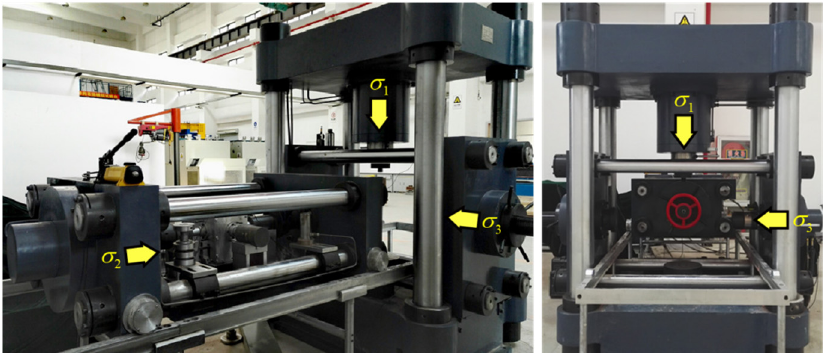
Figure 2. True triaxial electro-hydraulic servo test system.